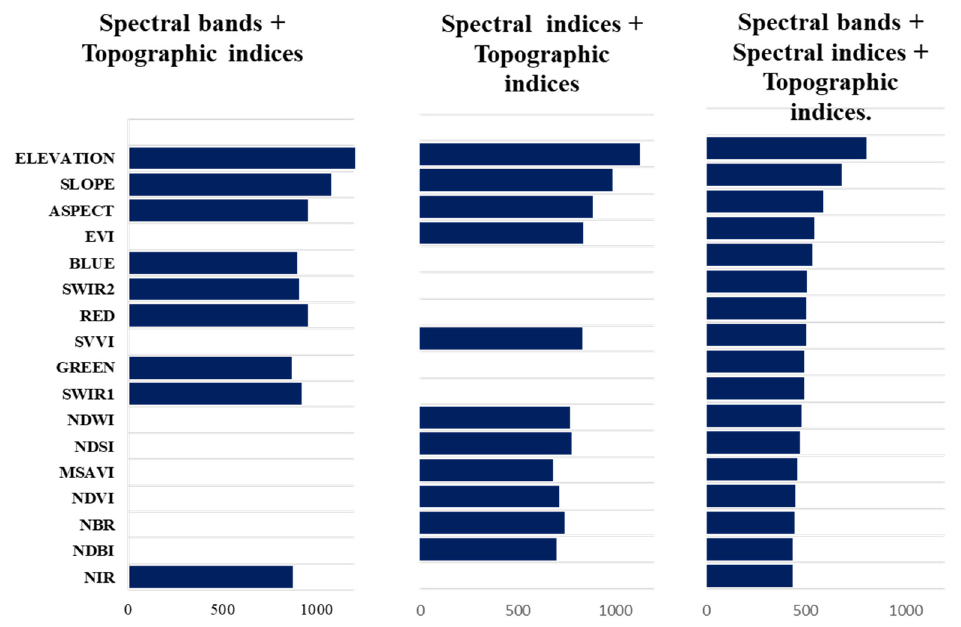
Figure 4. Variable importance analyses for random forest classifiers.